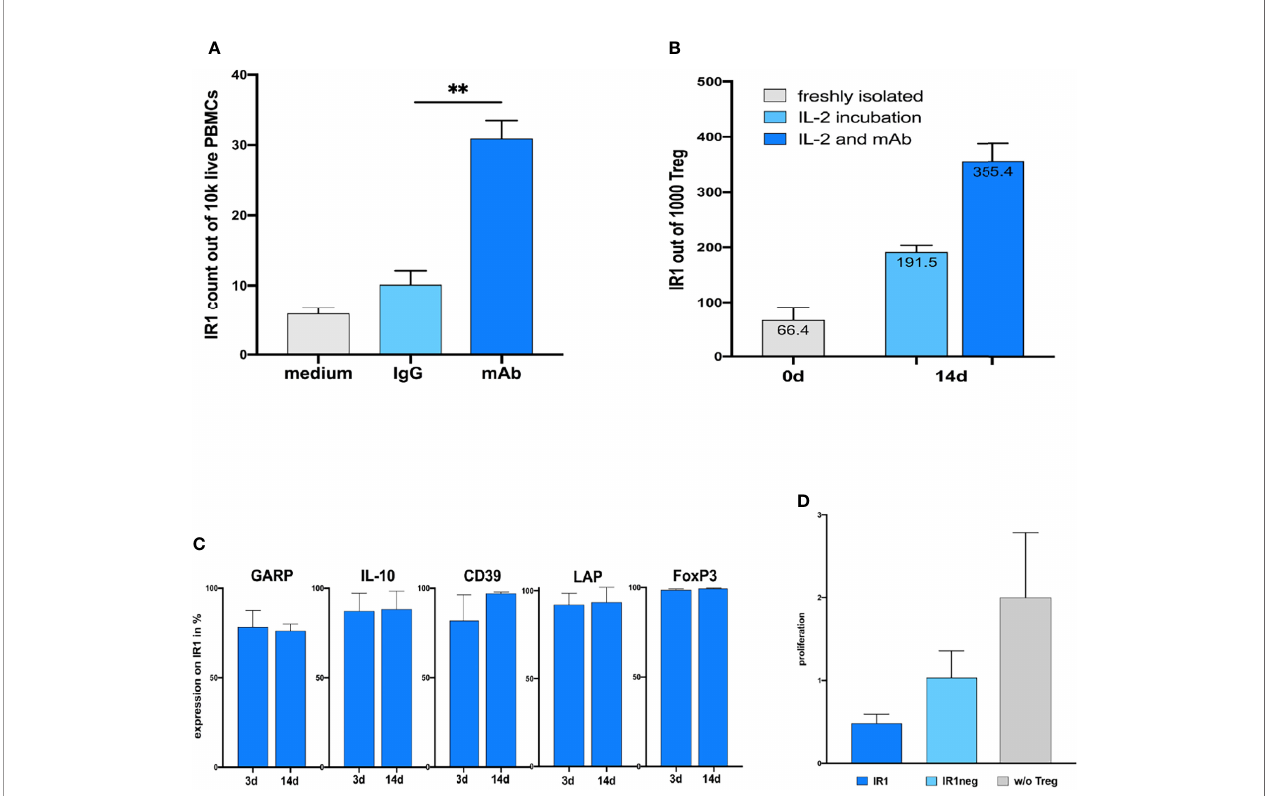
FIGURE 3 | (A) Coincubation of humanized TIRC7 agonist antibody signi fi cantly induce TIRC7+ IR1 cells in human PBMC cultures after 72h compared to IgG- control ex vivo (n=7). ** mAb = p.0025. (B) Exposure of puri fi ed CD25+CD4+ cells to IL-2 plus agonist anti-TIRC7 mAb leads to profound expansion of IR1 cells after 2 weeks. The absolute numbers of puri fi ed Treg cells after 2 weeks of expansion cultures are shown. The absolute numbers of IR1 cells in the presence of TIRC7 antibody plus IL-2 exceed those achieved in the IL-2 cultures alone by several fold. (C) Stability of suppressive phenotypes as re fl ected based on the expression of markers LAP, CD39, GARP, IL-10 and FOXP3 remain high and unchanged in expanded IR1+ cultures after 14 days. (D) In BrdU proliferation assay, expanded human IR1+ cells show more potent inhibition of lymphocyte activation in mixed lymphocyte culture (MLC) compared to IR1neg